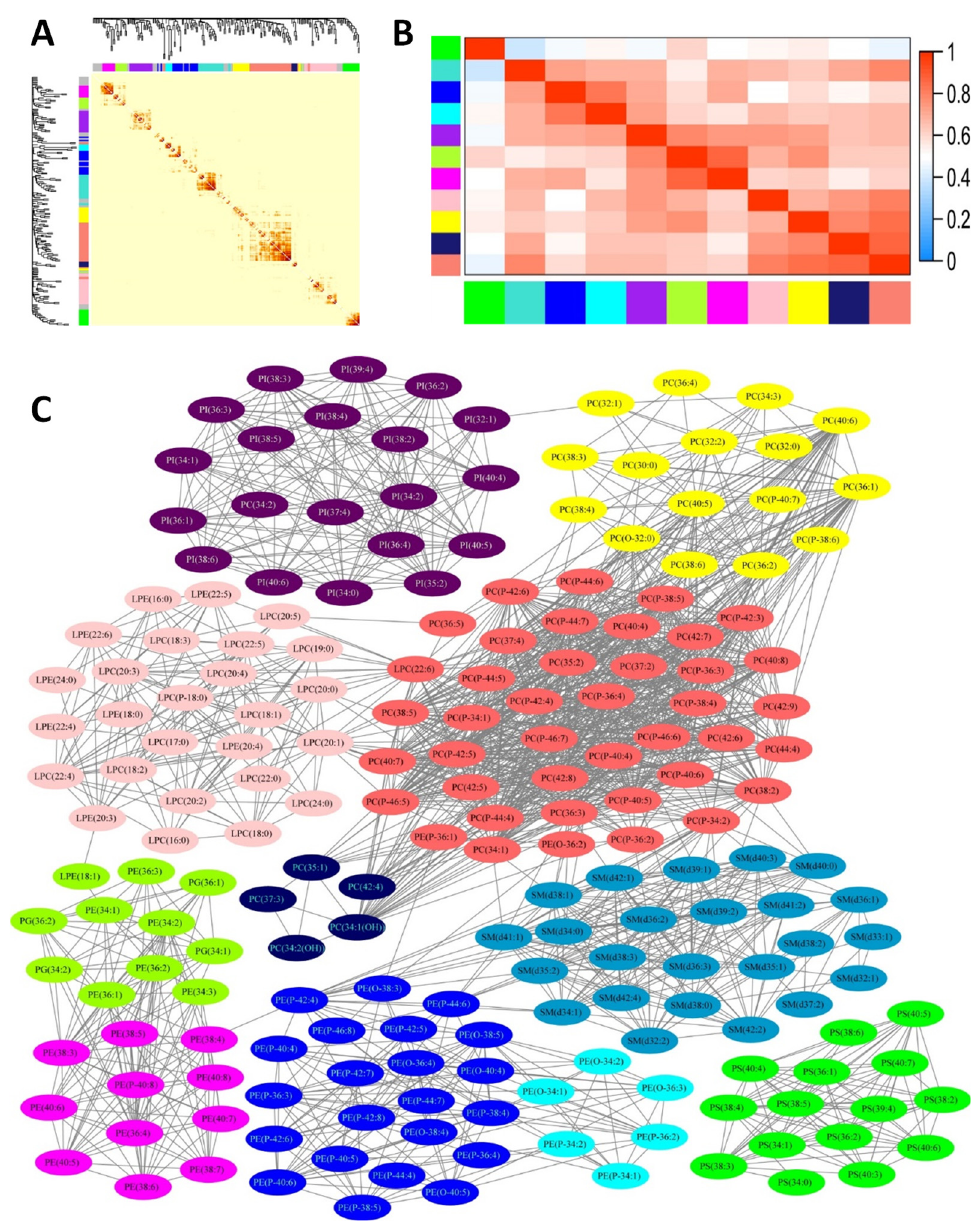
Figure 1. Weighted gene co-expression network analysis (WGCNA) of phospholipid profile. ( A ) Cluster dendrogram and heatmap correlation of 229 phospholipid molecular species. Color bars on the left and at the top represent 11 identified modules. Phospholipids that could not be clustered to any module are labeled gray. ( B ) Correlation heatmap among the 11 modules. Color bars on the left and at the bottom represent modules, and grid squares indicate Spearman’s correlation coefficients among module eigengenes. ( C ) Colors indicate the modules detected by topological overlap measure (blue and cyan: plasmanyl/plasmenyl PEs; magenta: diacyl PEs; greenyellow: diacyl PEs and PGs; salmon, yellow and midnightblue: PCs; green: PSs; purple: PIs; turquoise: SMs; pink: LPCs and LPEs). Table 4. Distribution of module eigengenes and their association with MoCA score 1 .